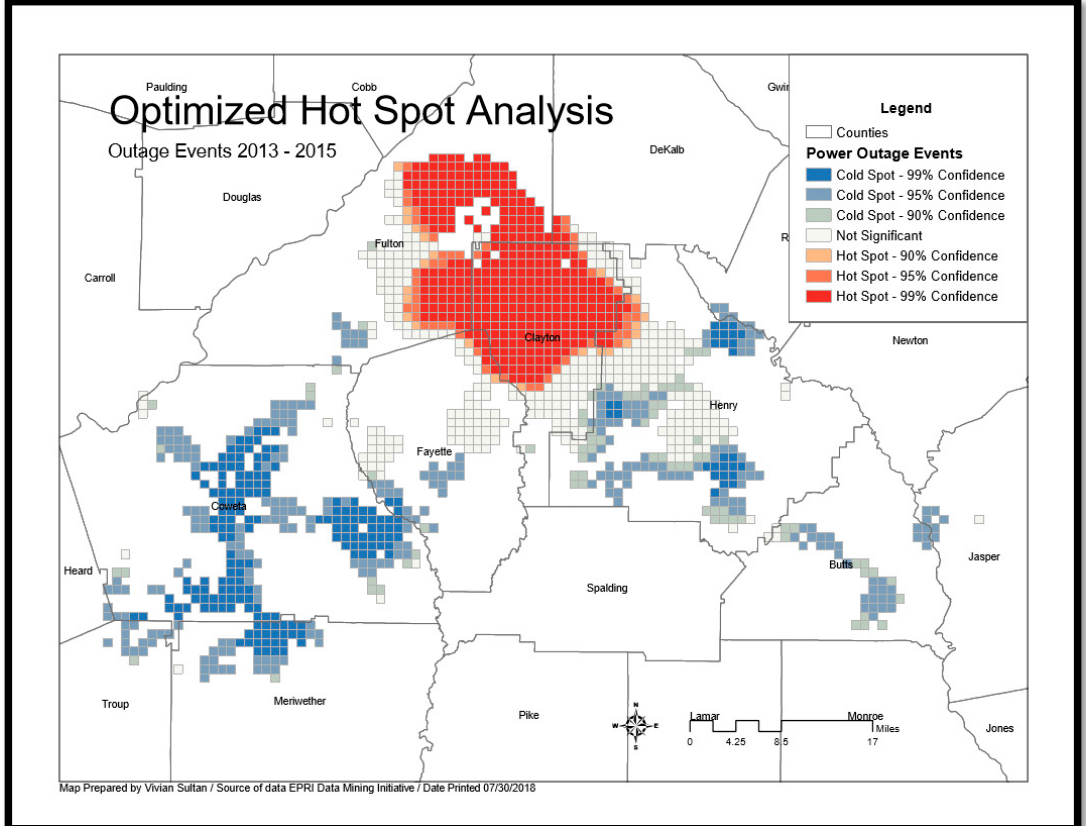
Figure 10. ArcGIS optimized hot-spot analysis Level 1 output map.